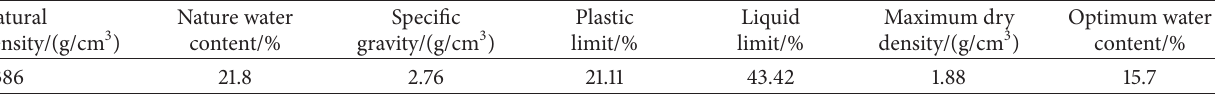
Table 1: Basic soil properties of Hongshan clay.